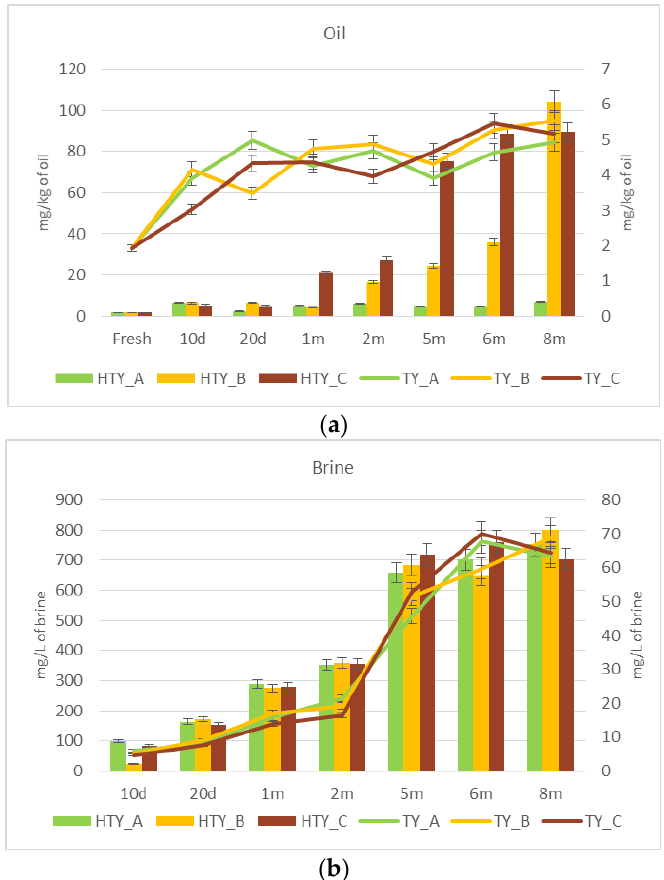
Figure 9. Hydroxytyrosol (HTY) and tyrosol (TY) in the oil fraction ( a ) and the brine ( b ) during the fermentation. Table 3. N-fold increase of hydroxytyrosol (HTY) and tyrosol (TY) in the different fractions (flesh, oil and brine) at the end of the de-bittering process, with respect to the initial concentration.